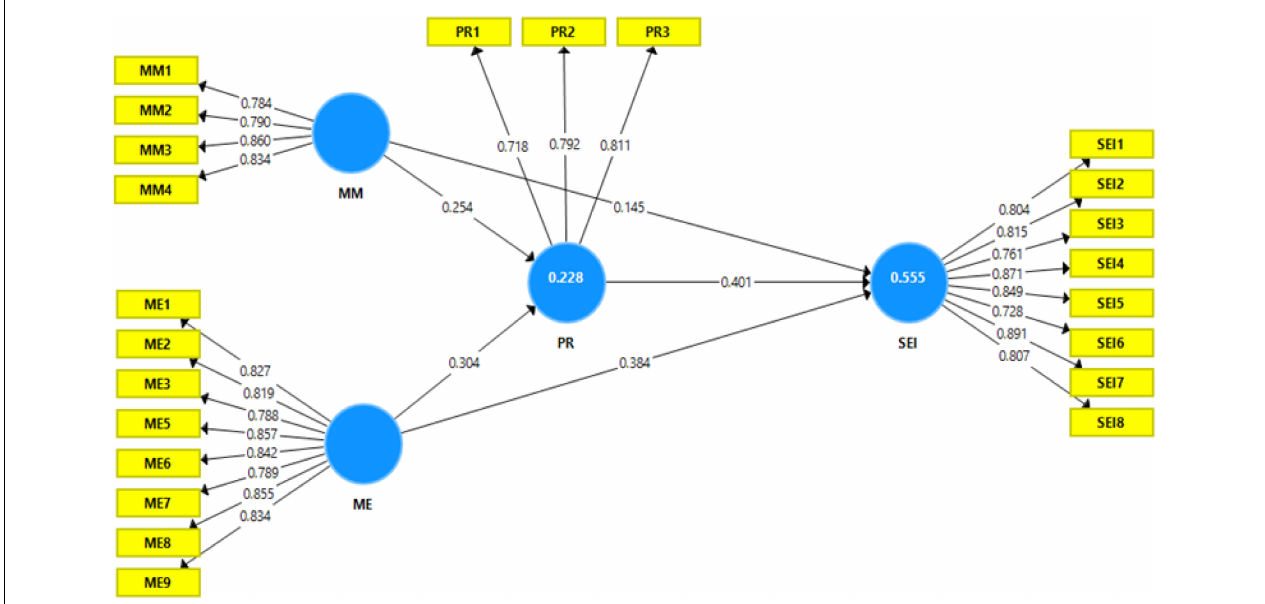
FIGURE 2 | Structural model